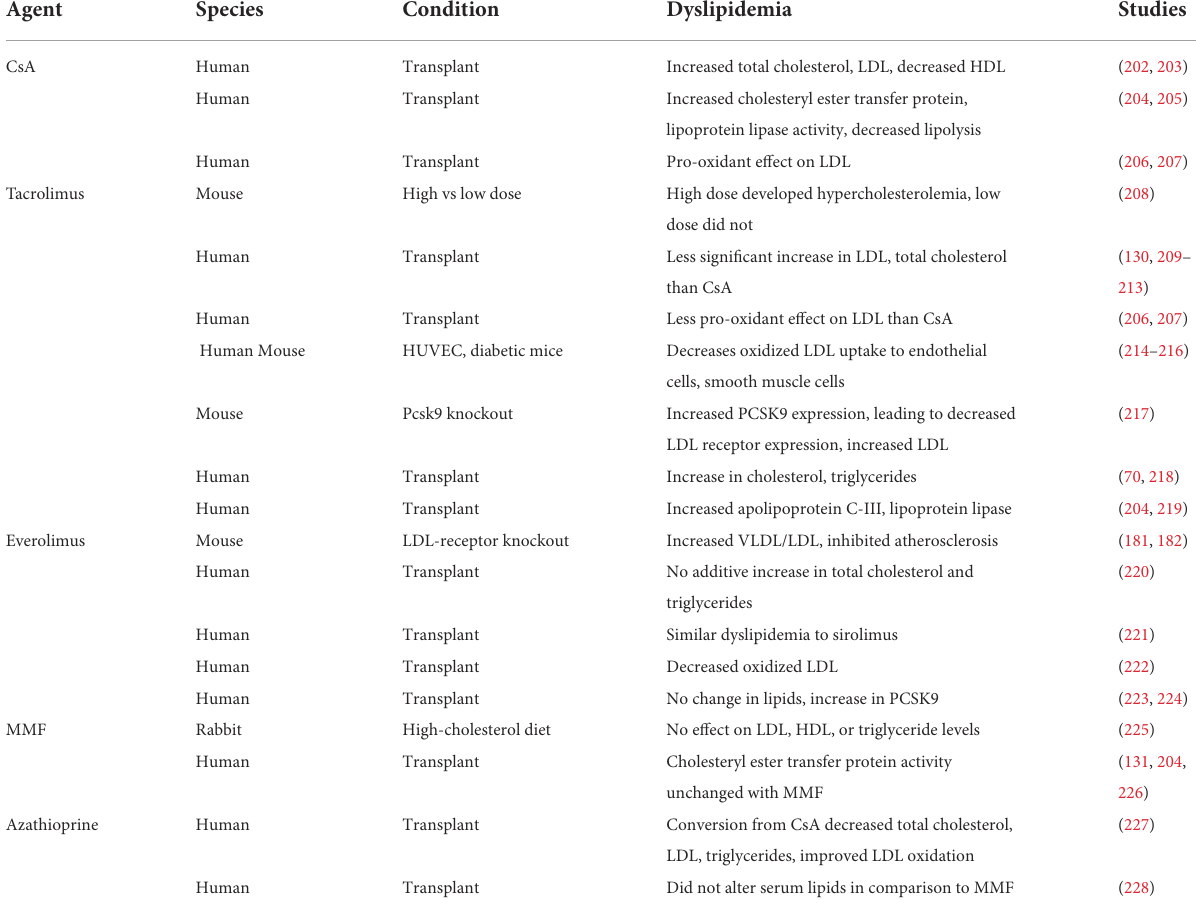
TABLE 6 Studies examining effects of immunosuppression on